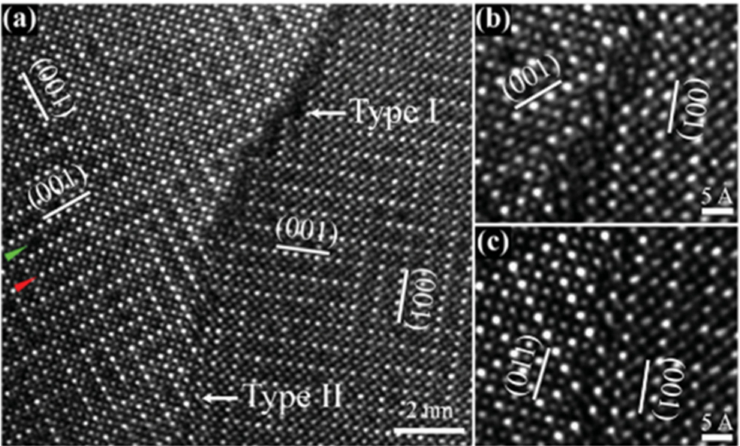
Figure 35. ( a ) HADDF-STEM of a GB exhibiting both dark and normal contrast regions, labelled as type I and type II, respectively. The {001} planes of the alternating L-rich/La-poor layers of different regions in the grain were marked to highlight the existence of nanodomains ( b ) magnified type I GB feature. ( c ) magnified type II GB feature [20]. Reproduced from [20] with permission from the Royal Society of Chemistry, Copyright